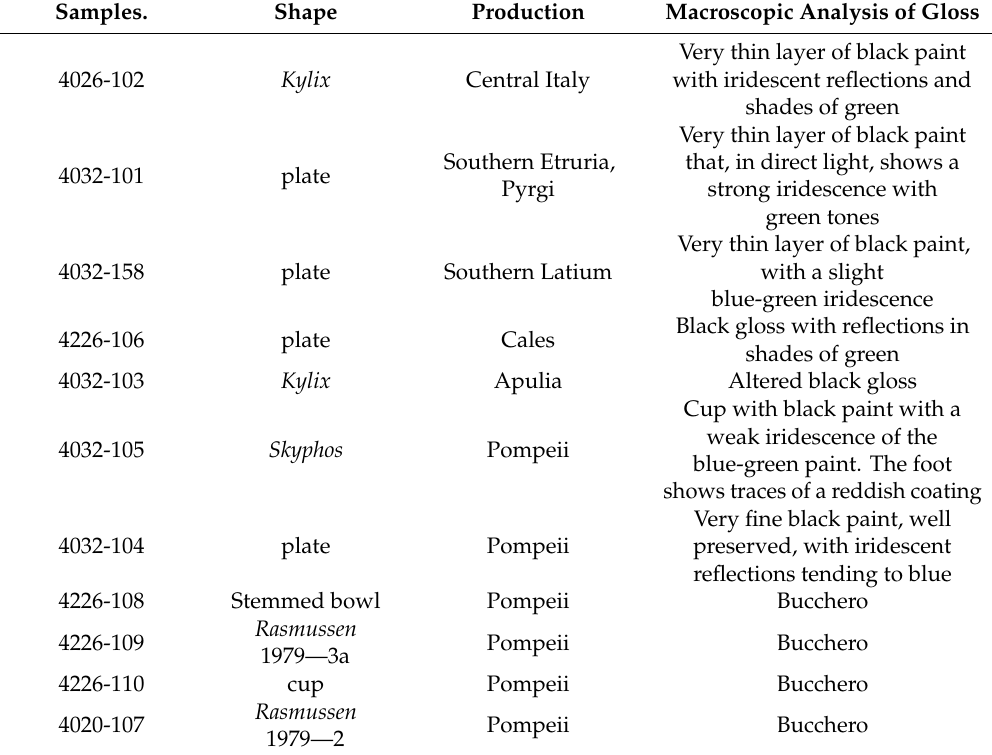
Table1. Macroscopicclassificationandhypothesizedprovenanceconsideringtypologyandmacroscopic features of each sample under